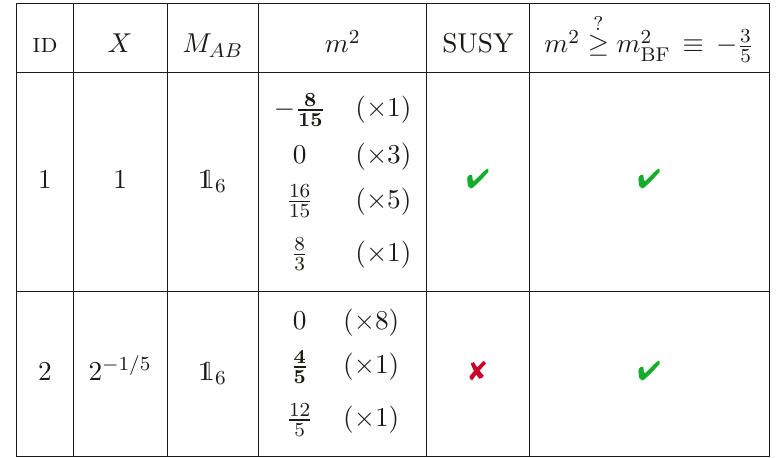
Table 2 . The embedding tensor/fluxes dictionary for the case of massive type IIA reductions on S 3 . The underlying 7D gauging is generically ISO(3), except when q = ˜ q = λ , where it degenerates to SO(3) [18].